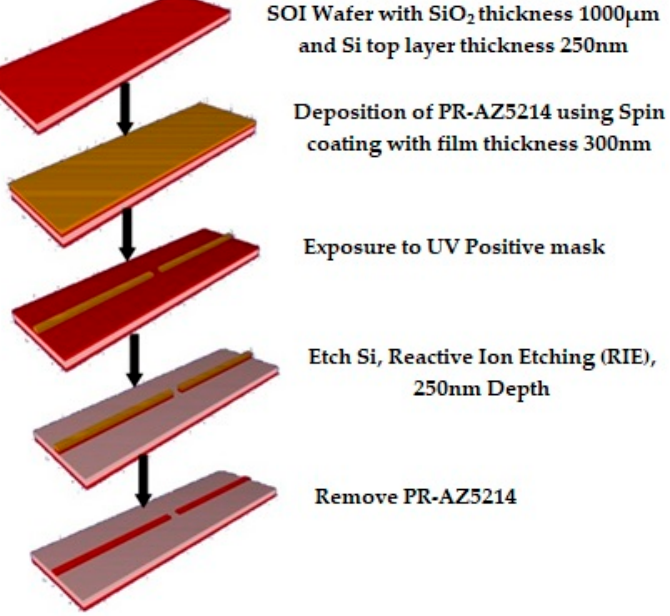
Figure 11. The process flow steps for the silicon on insulator (SOI) waveguide sensor simulated with the Intellisense software package.